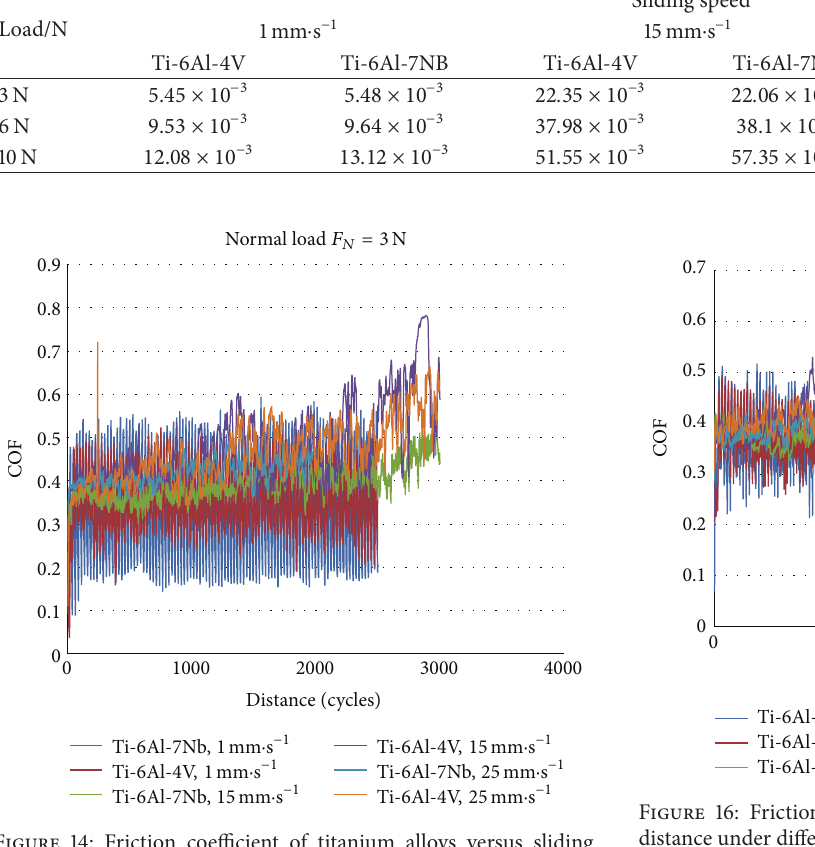
Figure 14: Friction coefficient of titanium alloys versus sliding distance under different sliding speed at 3N.